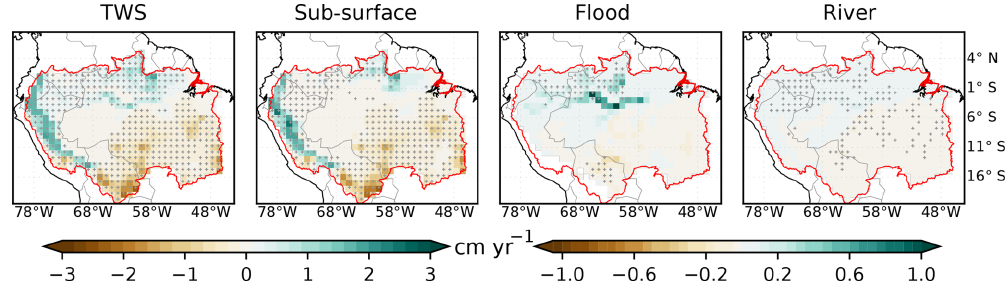
Figure 6. Temporal trend in simulated TWS and its components (i.e., sub-surface water, floodwater, and river water stores) for the period of 1980 to 2015 expressed in centimeters per year (cmyr − 1 ). Markers indicate significant trends at the 99% level. Note that the ranges of color bars differ among the